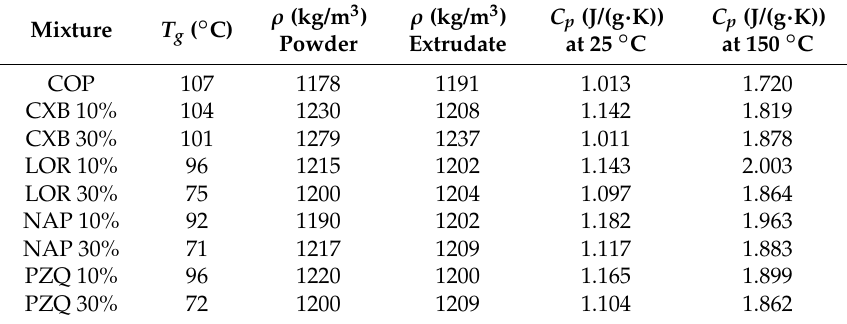
Table 2. Glass transition temperature identified by Brostow Chiu Kalogeras Vassilikou-Dova (BCKV) fit, true density, and heat capacity of the COP blends